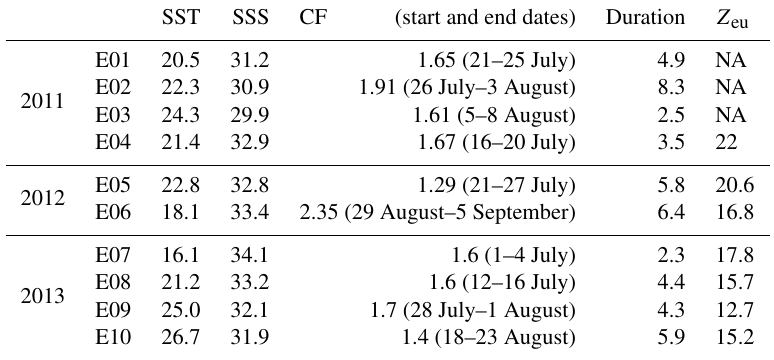
Table 1. Sea surface temperature (SST) in ◦ C, sea surface salinity (SSS) in gkg − 1 , chlorophyll a fluorescence (CF) in µgL − 1 , duration in days and euphotic depth ( Z eu ) in m during the E01–E10 observed from the surface mooring. NA: not available. SST SSS CF (start and end dates) Duration Z